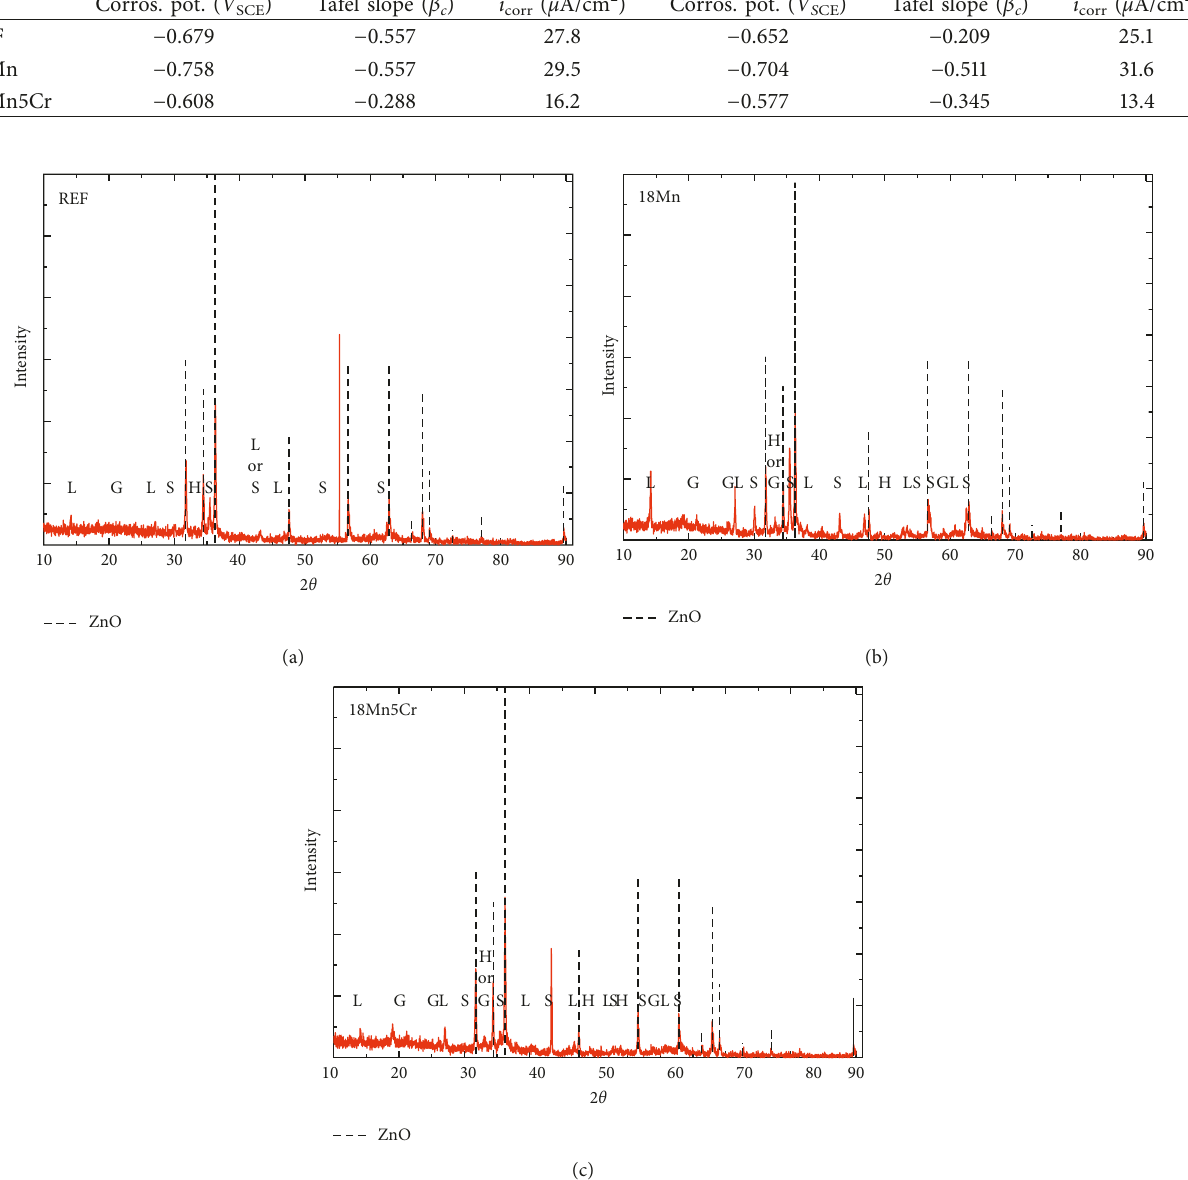
Figure 3: XRD patterns of the nonadherent rust (NAR) formed on (a) REF, (b) 18Mn, and (c) 18Mn5Cr for 56 days in 3.5% NaCl solution at 60 ° C, where G, L, S, and H represent goethite, lepidocrocite, magnetite (or maghemite), and hematite,